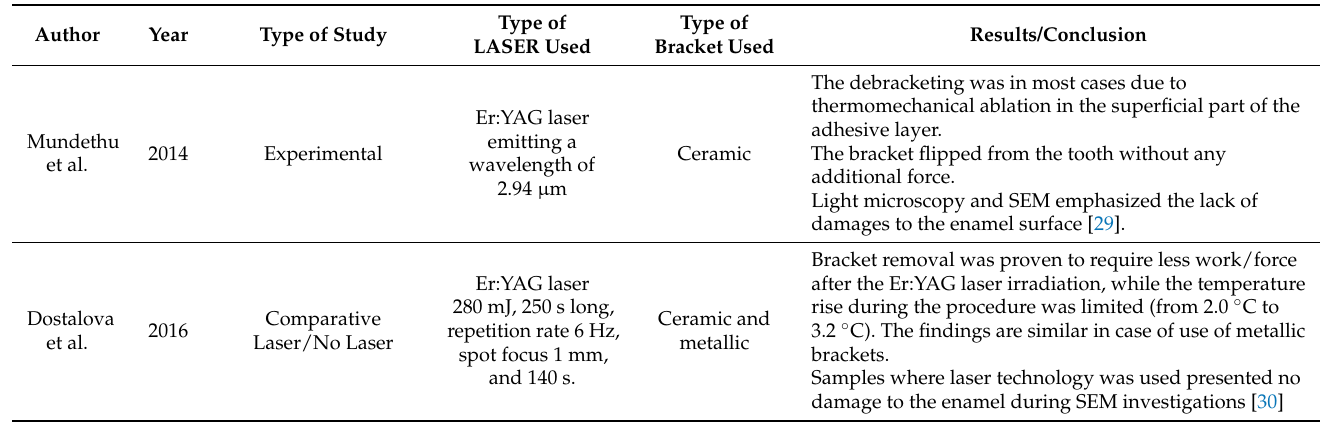
Table 2. Articles using Er:YAG